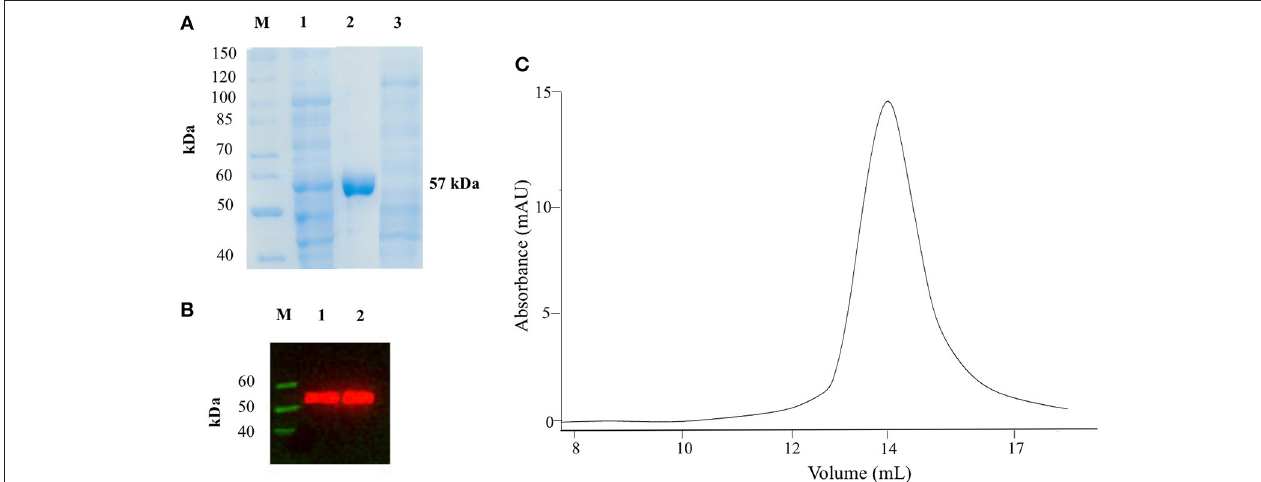
FIGURE 1 | SDS-PAGE, Western Blot and SEC analyses on recombinant AroH. (A) SDS-PAGE of recombinant AroH purification. Lane M: protein molecular weight markers; lane 1: 30 µ g of total bacterial lysate upon induction with IPTG; lane 2: 20 µ g of purified recombinant AroH after affinity chromatography; lane 3: 30 µ g of column flow-through. (B) Western blot of purified AroH. Lane M: molecular weight marker of His-tagged proteins; lane 1: 10 µ g of total lysate after induction with IPTG; lane 2: 5 µ g of purified recombinant AroH. (C ) Elution profile of 5 µ M AroH on a Superdex 200 SEC column equilibrated and run in 0.1M KP pH